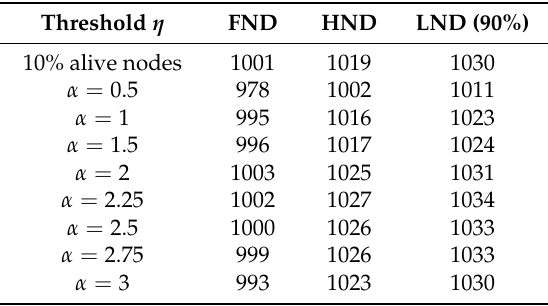
Table 8. Network lifetime with different α